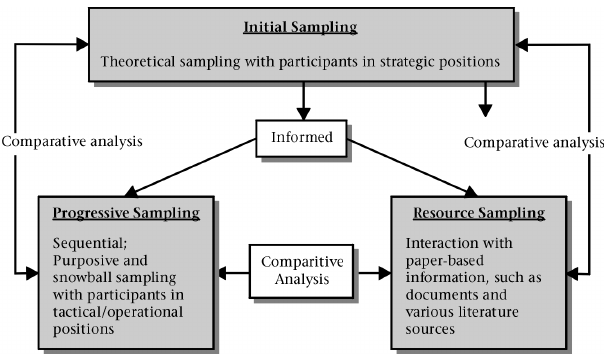
Figure 2: Graphic representation of the data collection process Data collection